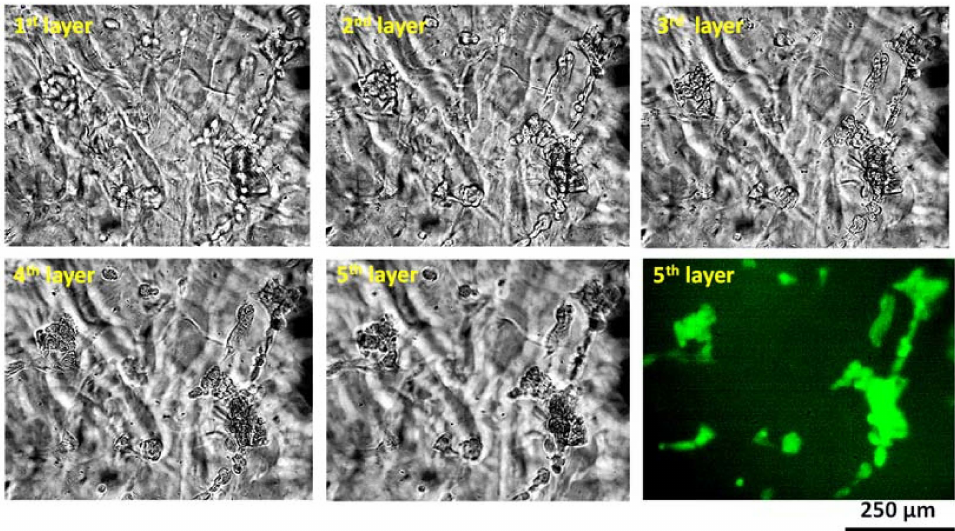
Figure 18. Height-based images captured to analyze the cell morphology. It was observed that cells started regaining their morphology after five incubation